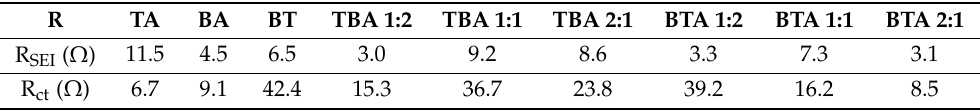
SEI resistance (R SEI ) and charge transfer resistance (R ct ) of cells containing thick-film